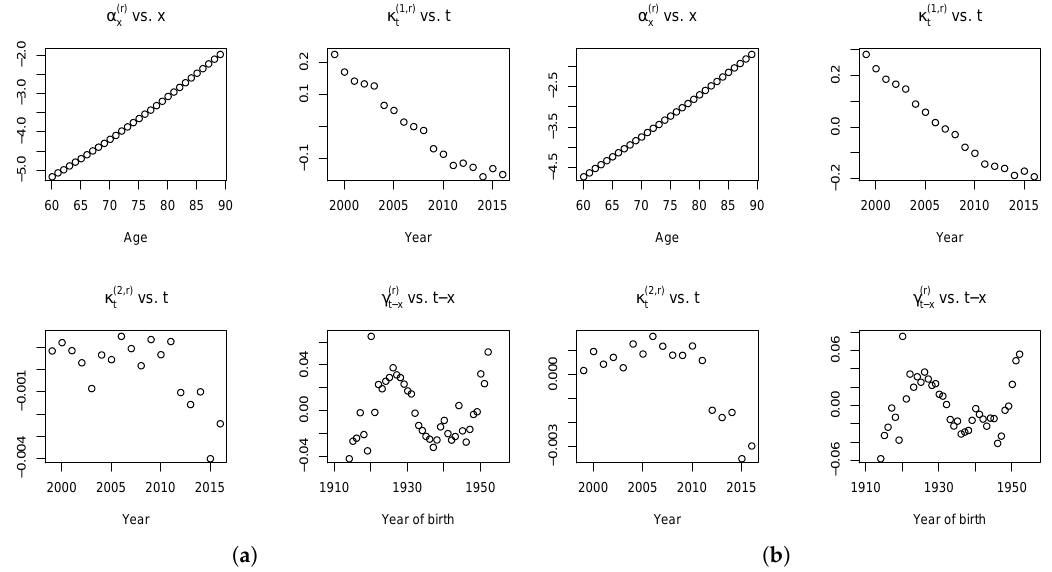
Figure 6. Estimated trend parameters of the Plat model for ( a ) UK females and ( b ) UK males. ( r ) Also in the Plat model case, the α x term is coherently increasing with age, the mortality